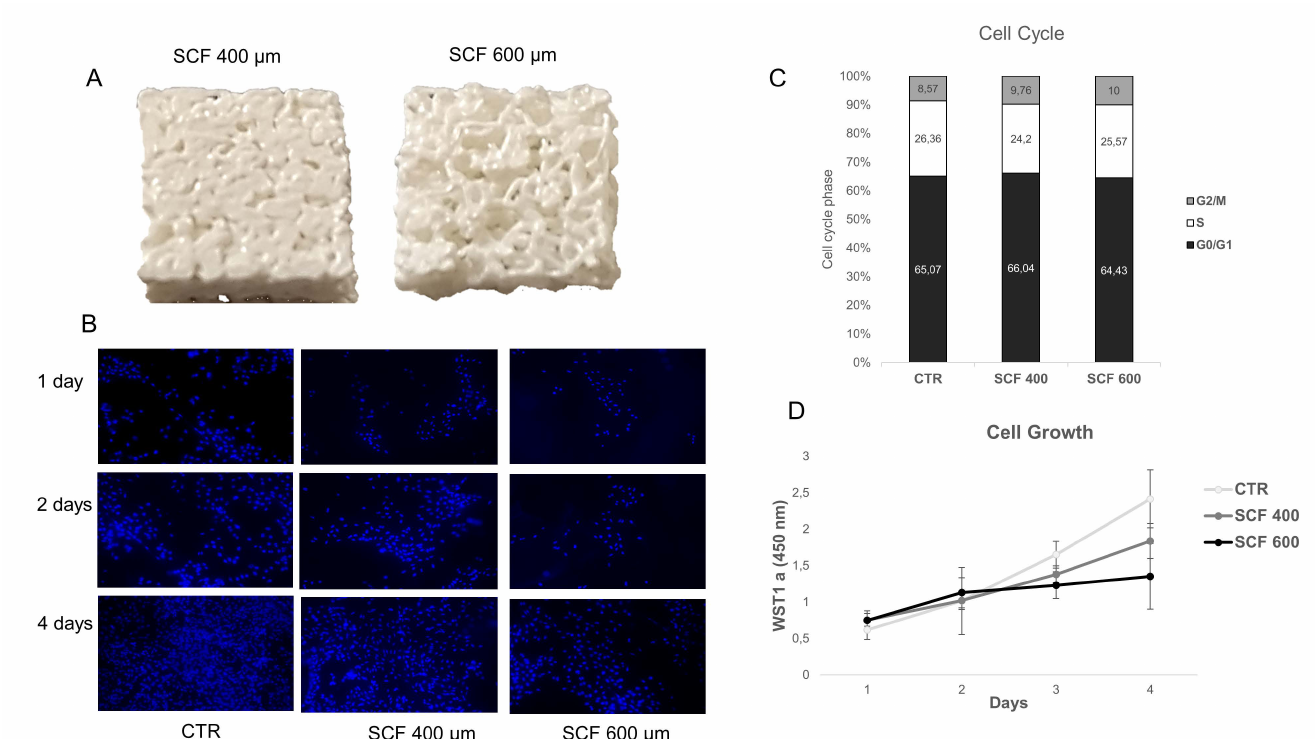
Figure 1. ( A ) 3D-printed scaffolds with a pore size of 400 ( left ) and 600 µ m ( right ). ( B ) Time evolution of SAOS-2 nuclei on SCF 400 scaffolds, SCF 600 scaffolds, and PLA control (CTR), revealed by Hoechst staining 33342, magnification 10 × ( C ) Cell cycle analysis of SAOS-2 seeded on SCF 400 scaffolds, SCF 600 scaffolds, and PLA control (CTR). ( D ) Cell growth analysis using the WST-1 assay of SAOS-2 seeded on SCF 400, SCF 600, and PLA control (CTR) (data are shown as mean SD).